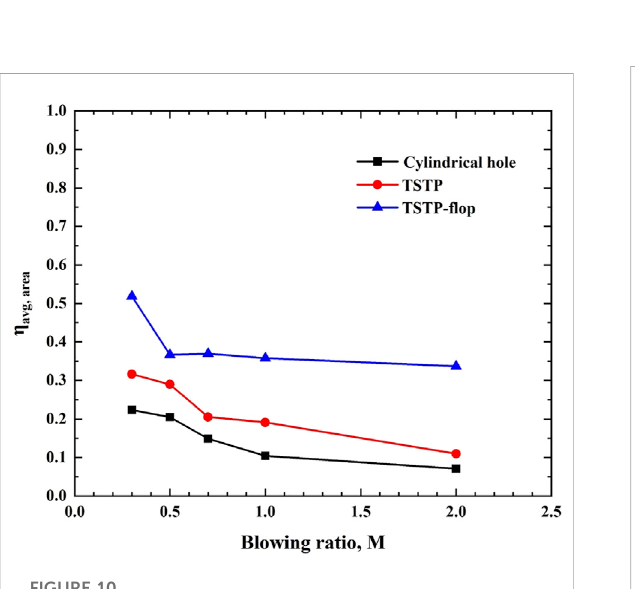
FIGURE 10 Area-averaged fi lm cooling effectiveness against blowing ratio for the different cooling hole con fi gurations.